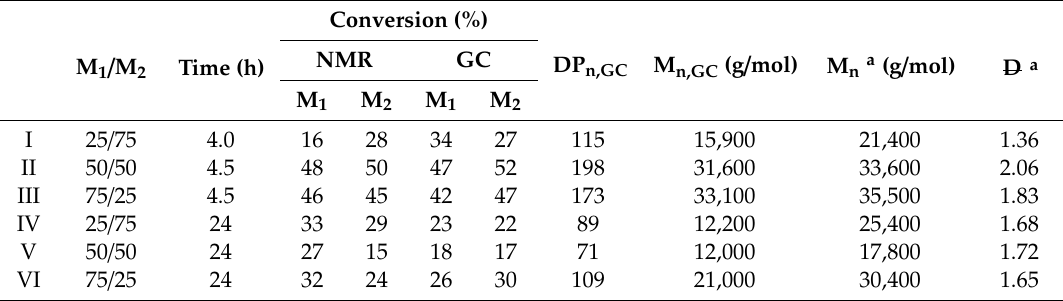
Table 1. Data for synthesis of AlHEMA / MMA copolymers by ATRP. Table 2. Data for the synthesis of graft copolymers P((HEMA- graft -PEG)- co -MMA) .